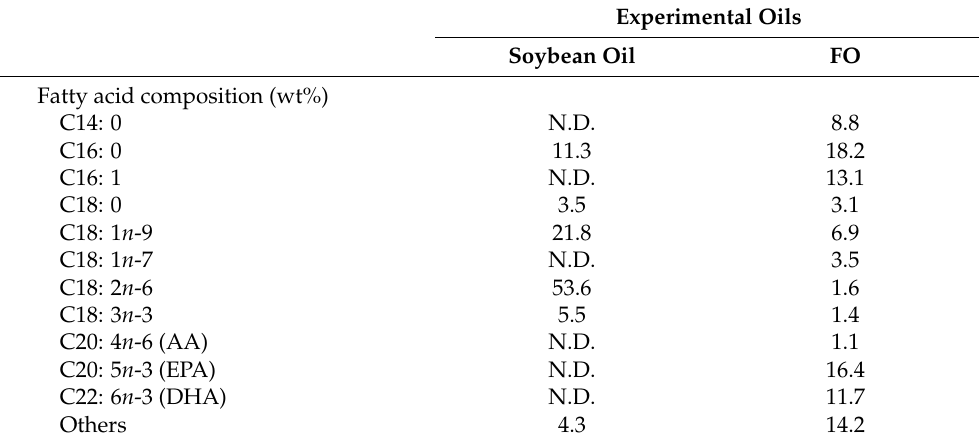
Table 2. Fatty acid composition of soybean oil and fish oil (FO).